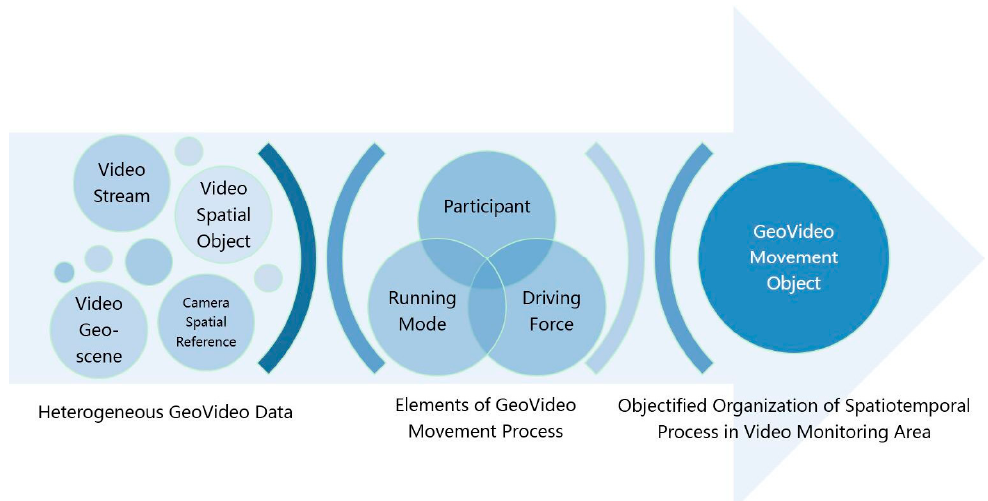
Figure 1. The semantic elements of spatiotemporal GeoVideo processes.